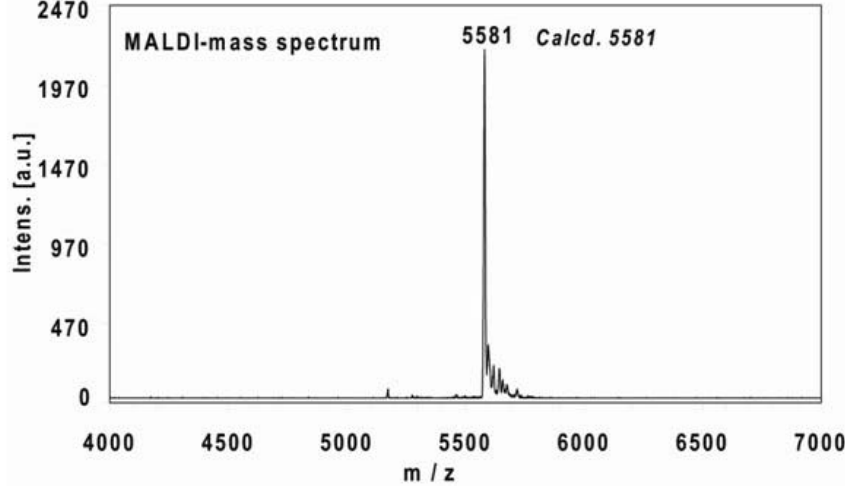
5. MALDI-mass spectrum of the crude conjugation reaction of 16-mer oligonucleotide internally labeled with the oligothiophene Eterneon TM -480/635 azide, after the precipitation step without further purification (first panel). MALDI-mass spectrum of the crude conjugation reaction of the 22-mer with the oligothiophene Eterneon TM 350/430 azide after the precipitation step without further purification (second panel) (unpublished